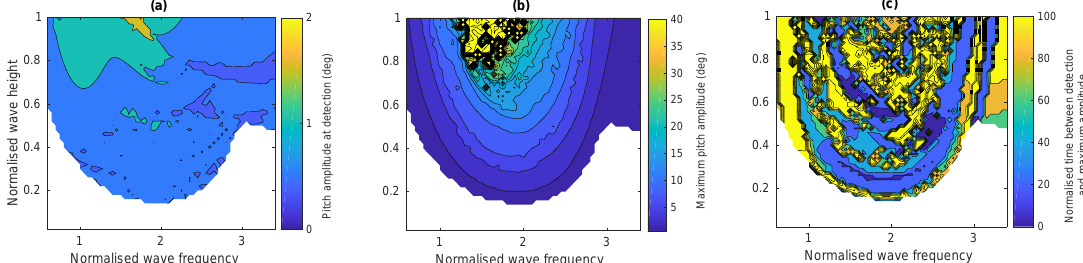
Figure 17. The performance of the early warning detection system in polychromatic waves. ( a ) The amplitude of the pitch displacement when the warning system detected parametric resonance. ( b ) The maximum amplitude of the pitch displacement when parametric resonance occurred (clipped at 40 ◦ , above which simulations always crashed). ( c ) The time between the when the warning system detected parametric resonance and when the maximum pitch displacement